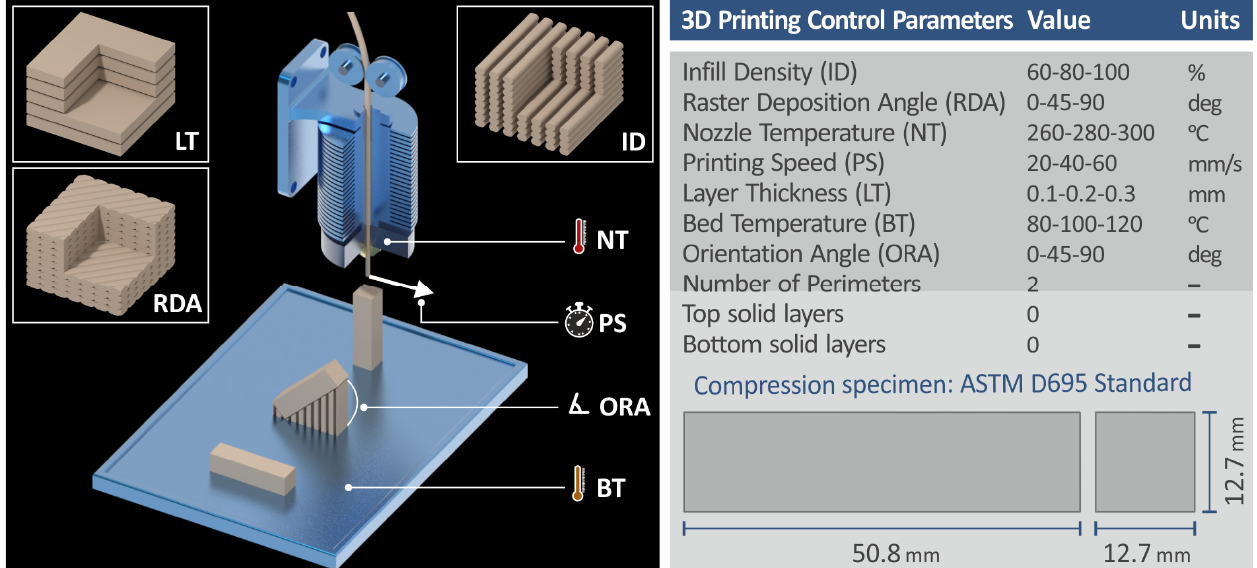
Figure 2. For the PC grade studied here, ( a ) weight loss vs. temperature graph (°C) (TGA), ( b ) endo graph (DSC).